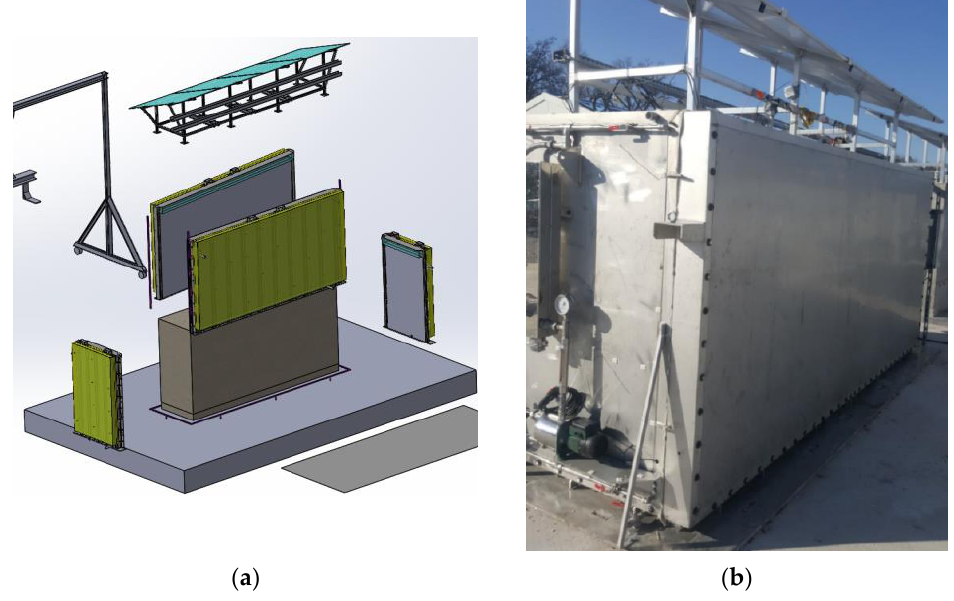
Figure 5. ( a ) Scheme of the pool setup used for the immersion of ODOBA blocks; ( b ) Picture of a pool in operation.